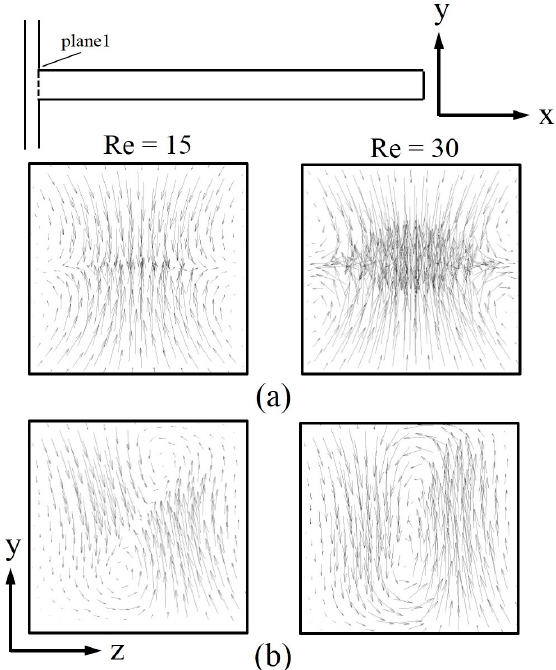
Figure 4. Velocity vector plots on y – z plane at inlet for Reynolds numbers, 15 and 30: ( a ) Micromixer with simple T -joint inlet; and ( b ) micromixer with tangentially aligned input